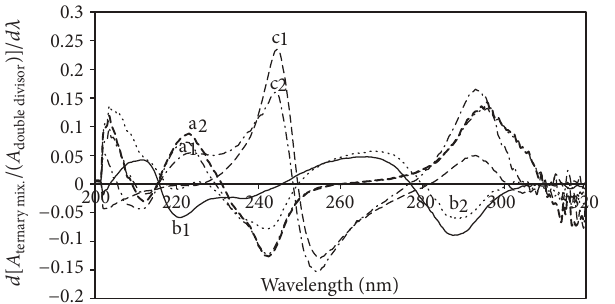
F 7: e coincident spectra of the �rst derivative of the